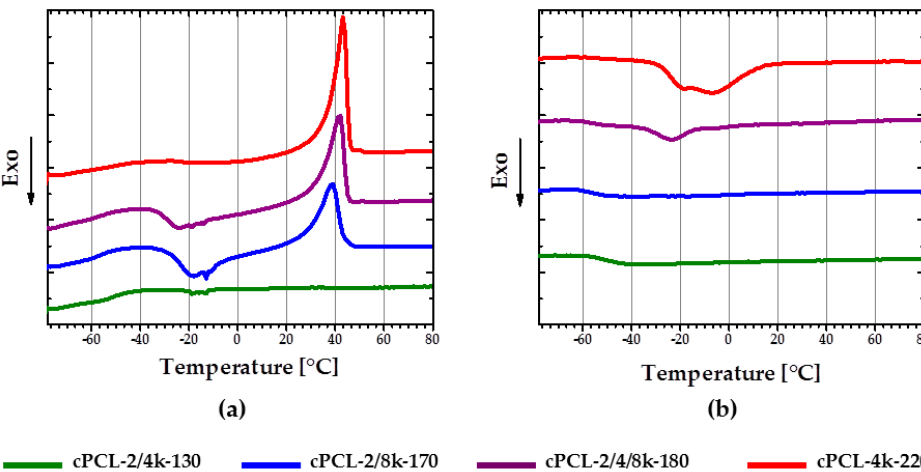
Figure 6. ( a ) DSC second heating; and ( b ) DSC first cooling curves of polyurethane foams with different polyol chain lengths after extraction in N , N -dimethylformamide (DMF). Heating and cooling rates were 3 K · min − 1 .